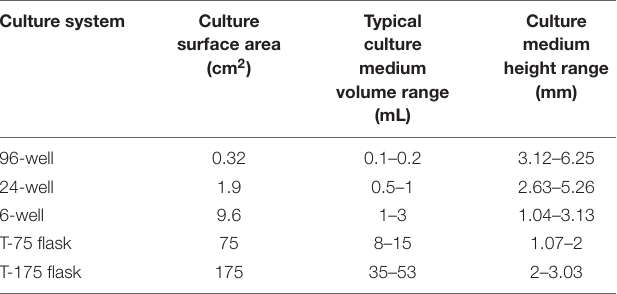
TABLE 1 | Inherent variations in oxygen diffusion distances (culture medium height) due to the dimensions of typically utilized plastic cell culture systems.